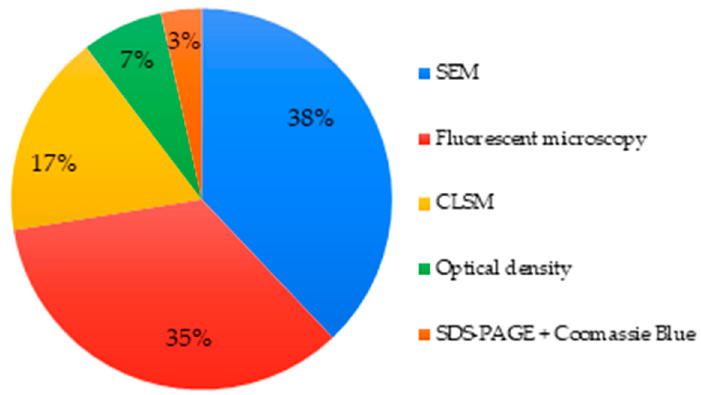
Figure 8. Techniques used to assess cell adhesion/attachment of